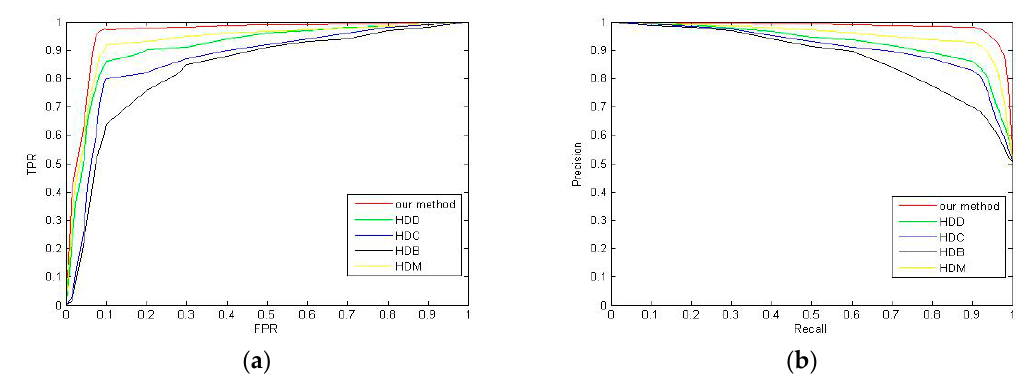
Figure 9. ( a ) Receiver operating characteristic (ROC) curves of our method and four competing methods with different colors that represent different methods. ( b ) Precision–recall curves of our method and four competing methods with different colors that represent different methods.